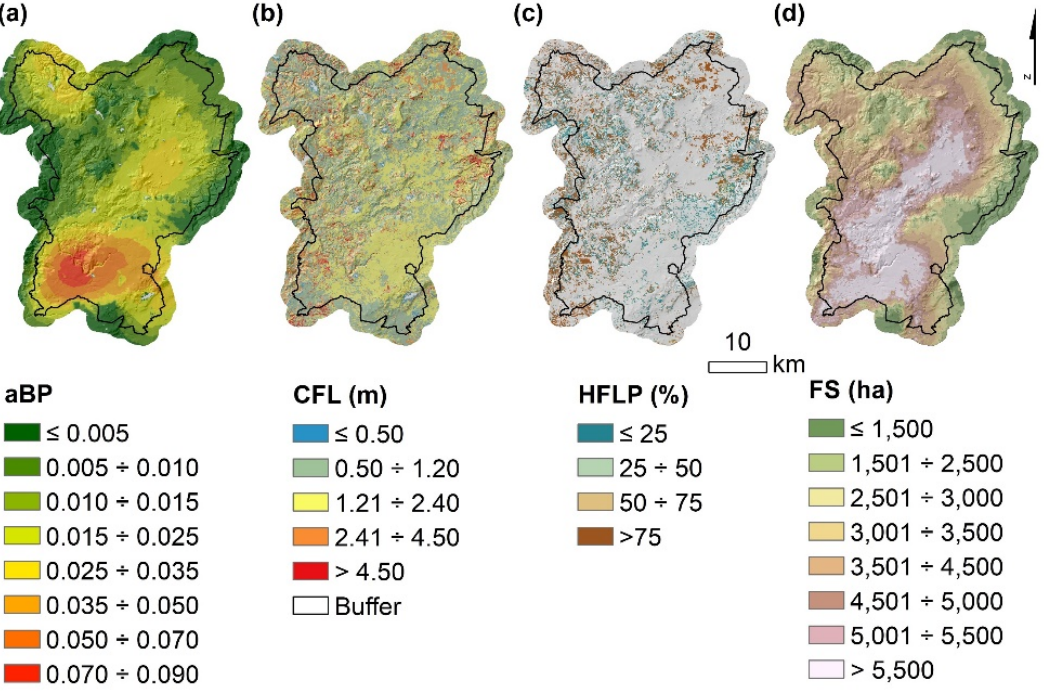
Figure 4. Maps of annual burn probability (aBP) ( a ), conditional flame length (CFL) ( b ), high flame length probability (HFLP) ( c ), and fire size (FS) ( d ) for the NA (no abandonment) conditions.